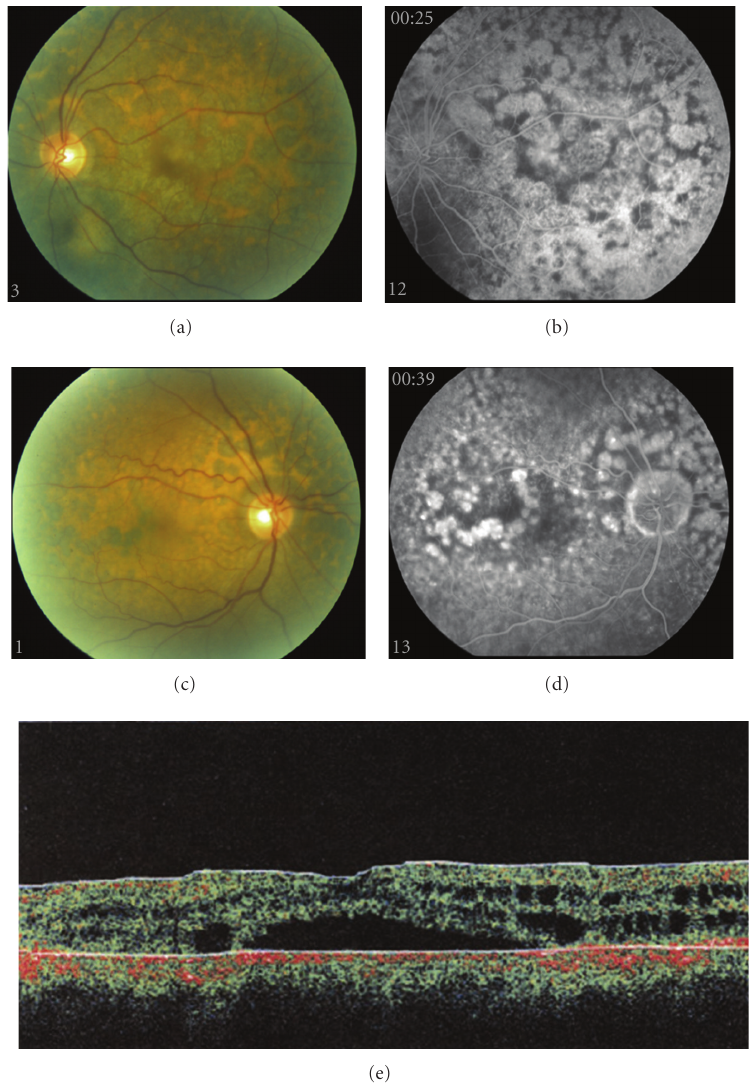
Figure 3: Color fundus photos of both eyes show nummular plaque-like patches at the level of the retinal pigment epithelium. Fluorescein angiography shows round areas of transmission defects as well as fine staining within these regions. OCT of the left eye shows intraretinal cysts, subretinal fluid, as well as disruption of the retinal pigment